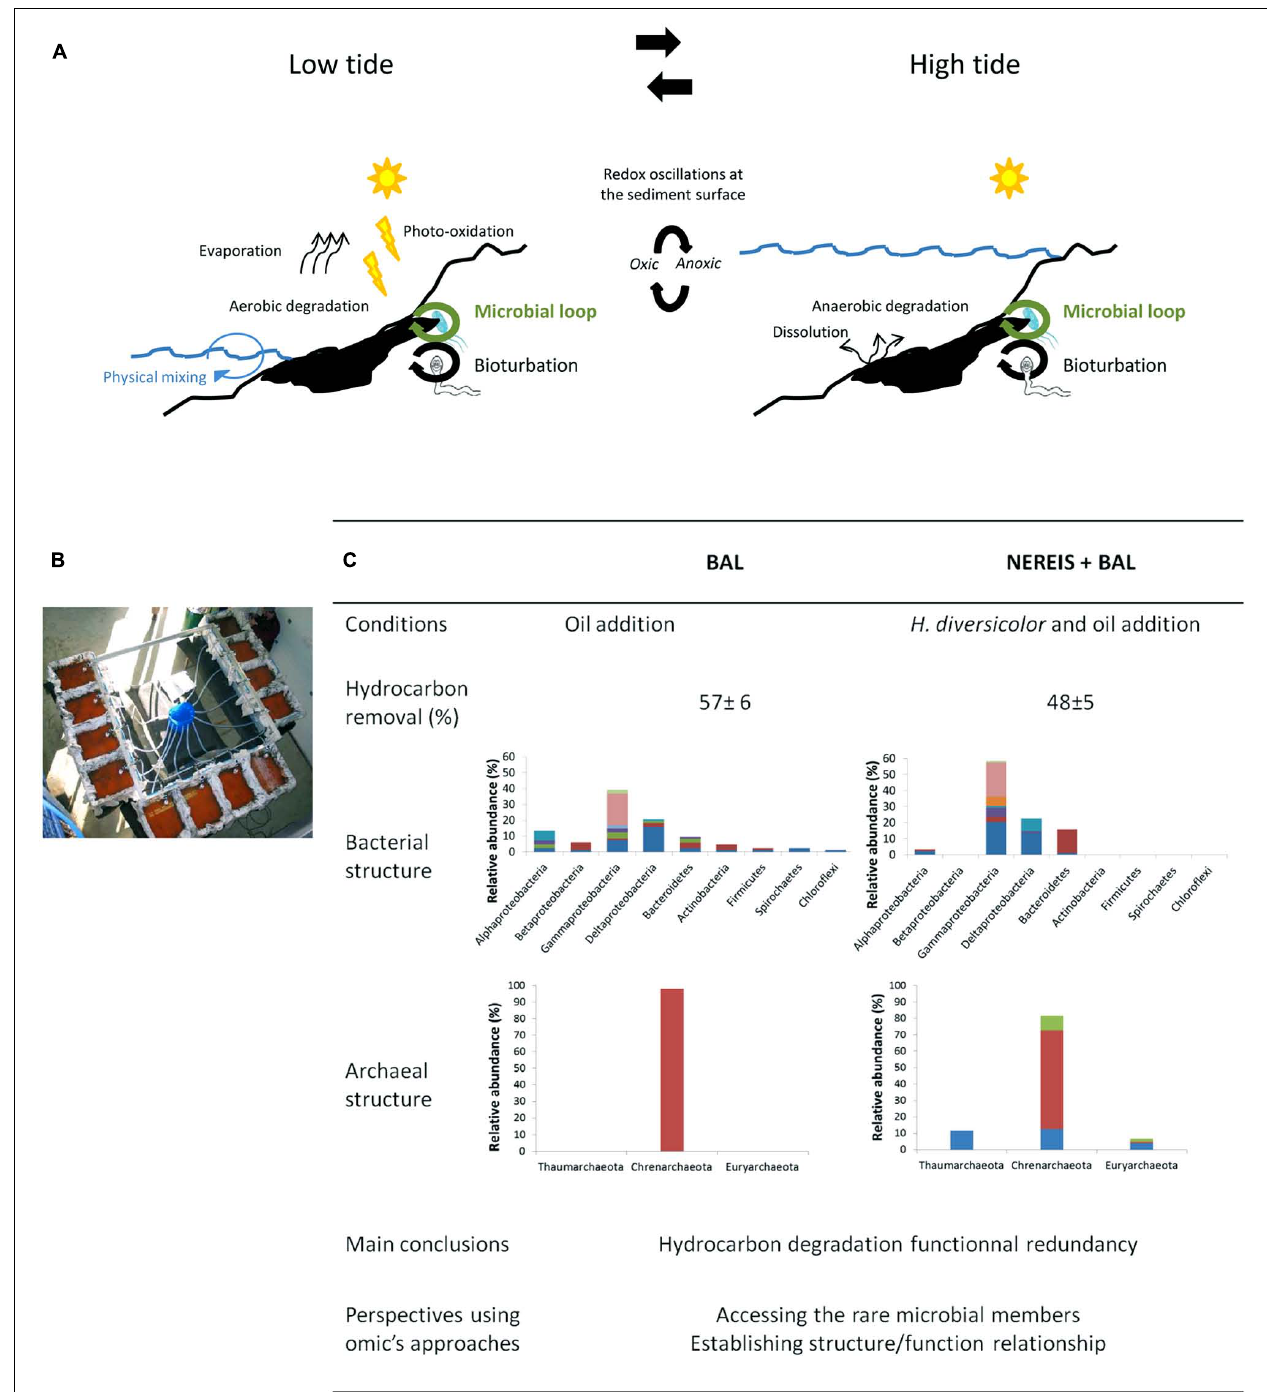
FIGURE 1 | Mimicking environmental conditions in experimental ecology. (A) Schematic overview of the main abiotic and biotic mechanisms determining the fate of hydrocarbons in coastal marine sediments according to the tide level. At the intertidal zone, where redox conditions oscillate at the sediments’ surface, microbial communities alternate aerobic and anaerobic hydrocarbon degradation processes. Bioturbation processes by macrofauna include sediments reworking, oil burying, and micro-scale oxygen oscillations into the sediments.The microbial loop is controlled by top-down (predation by